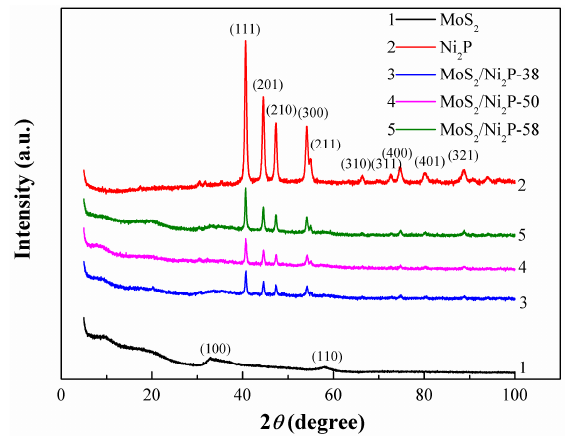
Figure 1. XRD patterns of MoS 2 , Ni 2 P, and three MoS 2 /Ni 2 P hybrids.